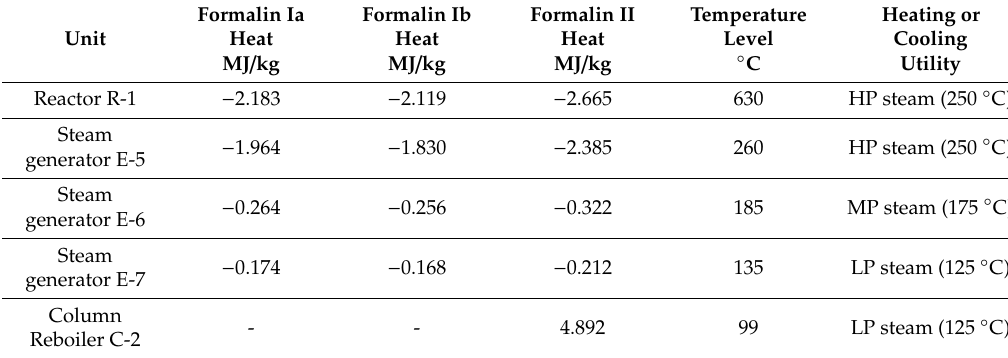
Table 11. Heat demand and excess of formalin synthesis from methanol. HP: high pressure (39.7 bar), MP: medium pressure (8.9 bar) and LP: low pressure (2.3